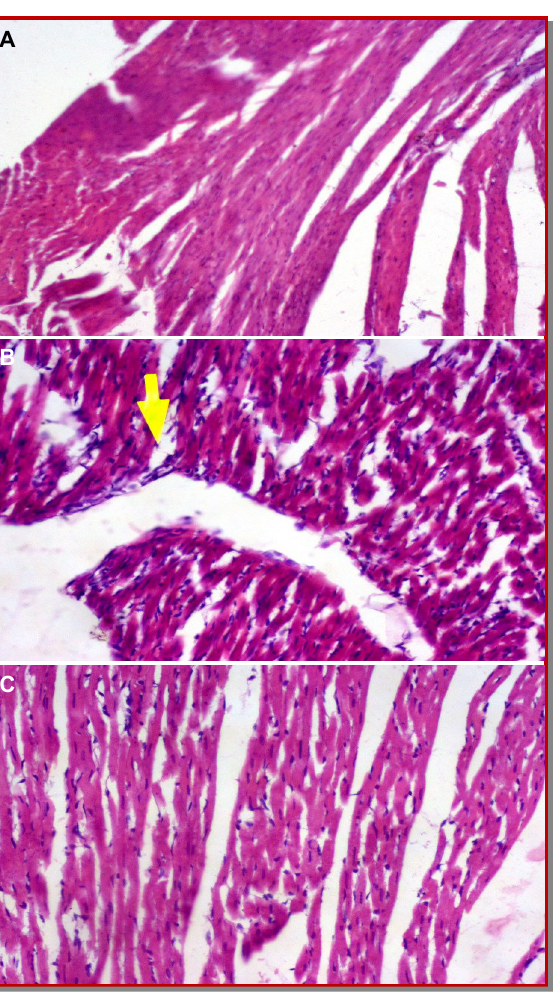
Figure 1: Representative photograph of sections of myocardi- um under light microscope of rats treated with either distilled water (A), adrenaline (2 mg/kg/day for 2 days) (B) and am- lodipine (5 mg/kg/day for 14 days) plus adrenaline (from 15 th day, 2 injection 24 hours apart) (C). H & E 20